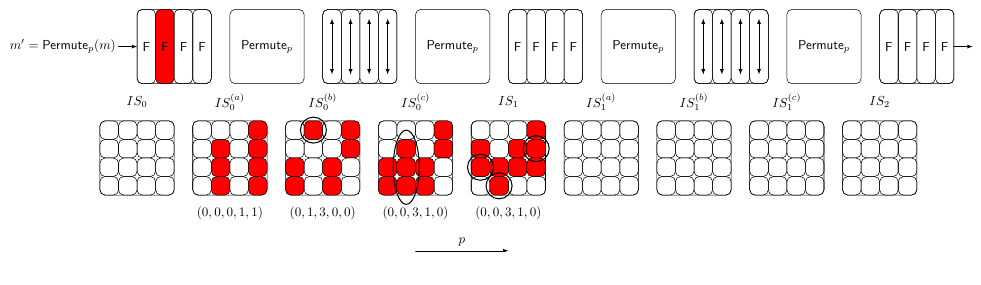
Figure 8: A differential trail of the form (2 → 2 → 2) in SE K , 3 , where the number of active cells of two active columns in IS ( a ) is different and where Permute p is instantiated by the 0 original cell permutation of Midori